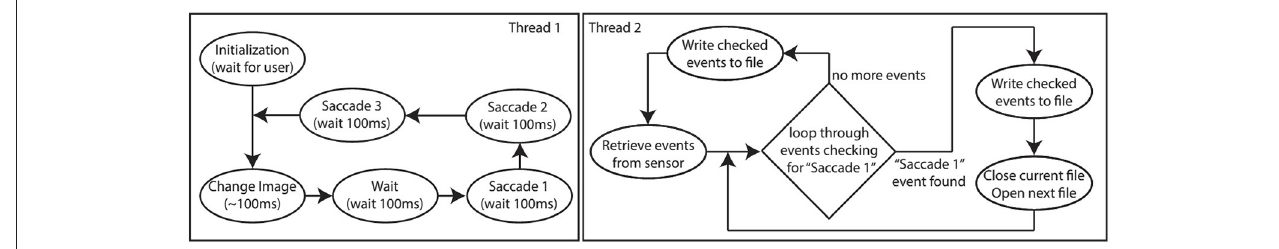
FIGURE 3 | Software flow diagram of the PC code showing two threads. Thread 1 (left) controls the timing of microsaccades and changing of images on the screen, while thread 2 (right) controls acquisition of the event data and writing it to disk.